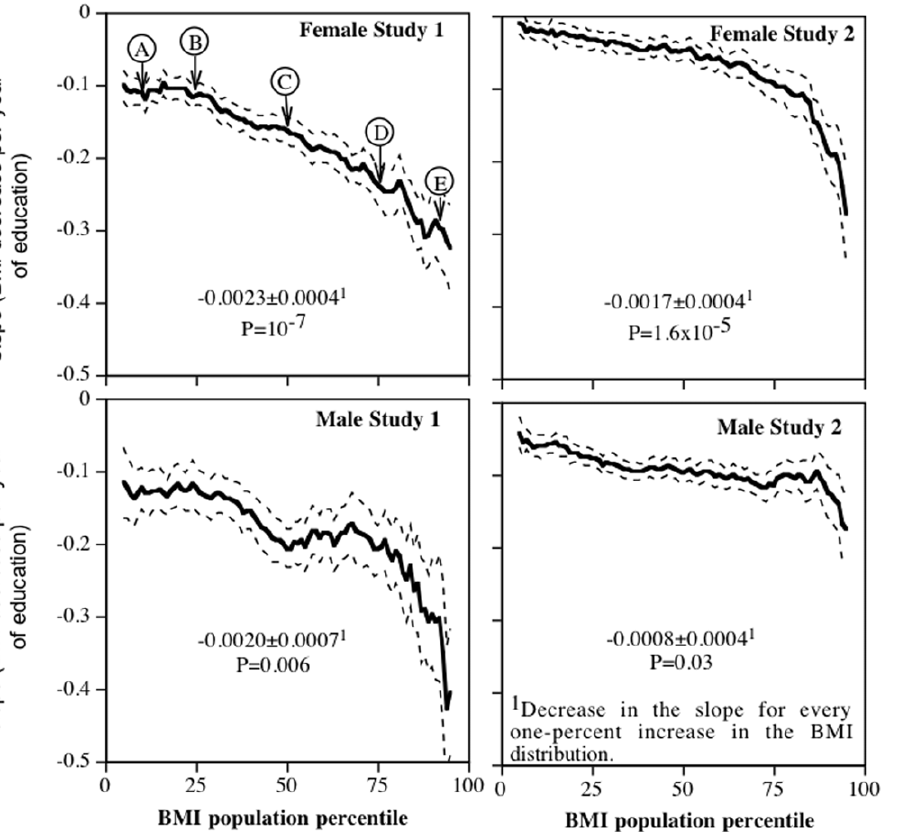
Figure 2. Percentile plot showing the slope for BMI vs. years of education (Y-axis) at each percentile of the BMI distribution (X-axis). For example, each addition year of education in Study 1 females was associated with a BMI decrease of (slope 6 SE) 2 0.117 6 0.018 kg/m 2 at the 10 th percentile of their BMI distribution (A), 2 0.117 6 0.016 kg/m 2 at their 25 th percentile (B), 2 0.165 6 0.020 kg/m 2 at their 50 th percentile (C, the median), 2 0.245 6 0.029 kg/m 2 at their 75 th percentile (D), and 2 0.300 6 0.046 kg/m 2 at their 90 th percentile (E, compare with Figure 1). The dashed lines designate one standard error. Data adjusted for age, race, physical activity, and diet. Study 1 included additional adjustment for parental adiposity.